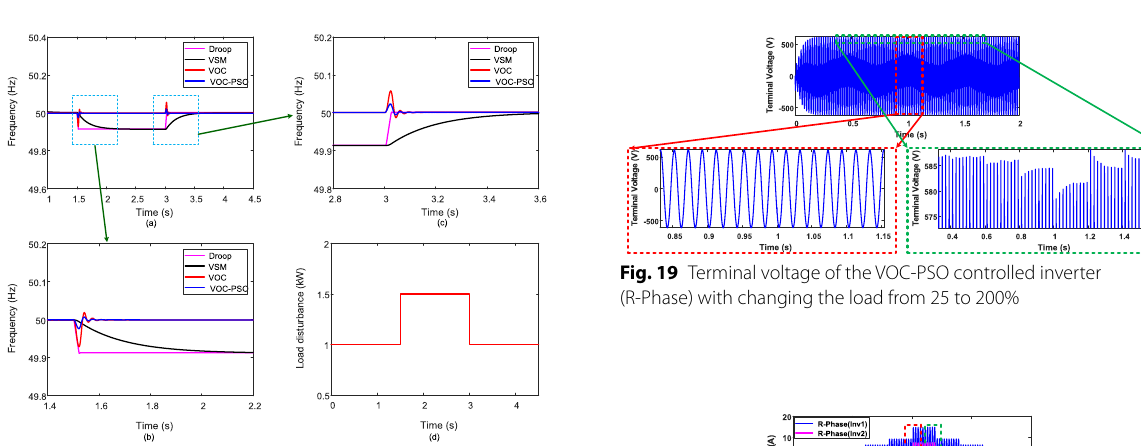
Fig. 16 a Frequency response in islanded mode with droop control, VSM, VOC, and VOC-PSO during a moderate load transition, b , c Zoomed-in look at a , d Disturbance in load